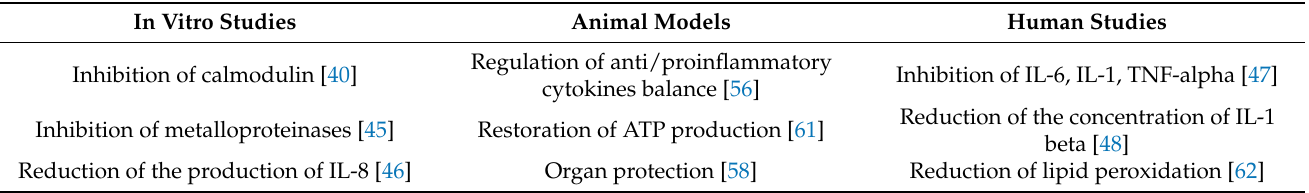
Table 2. Current data on the physiological effects of melatonin, which may be beneficial in bacterial or viral infections. In Vitro Studies